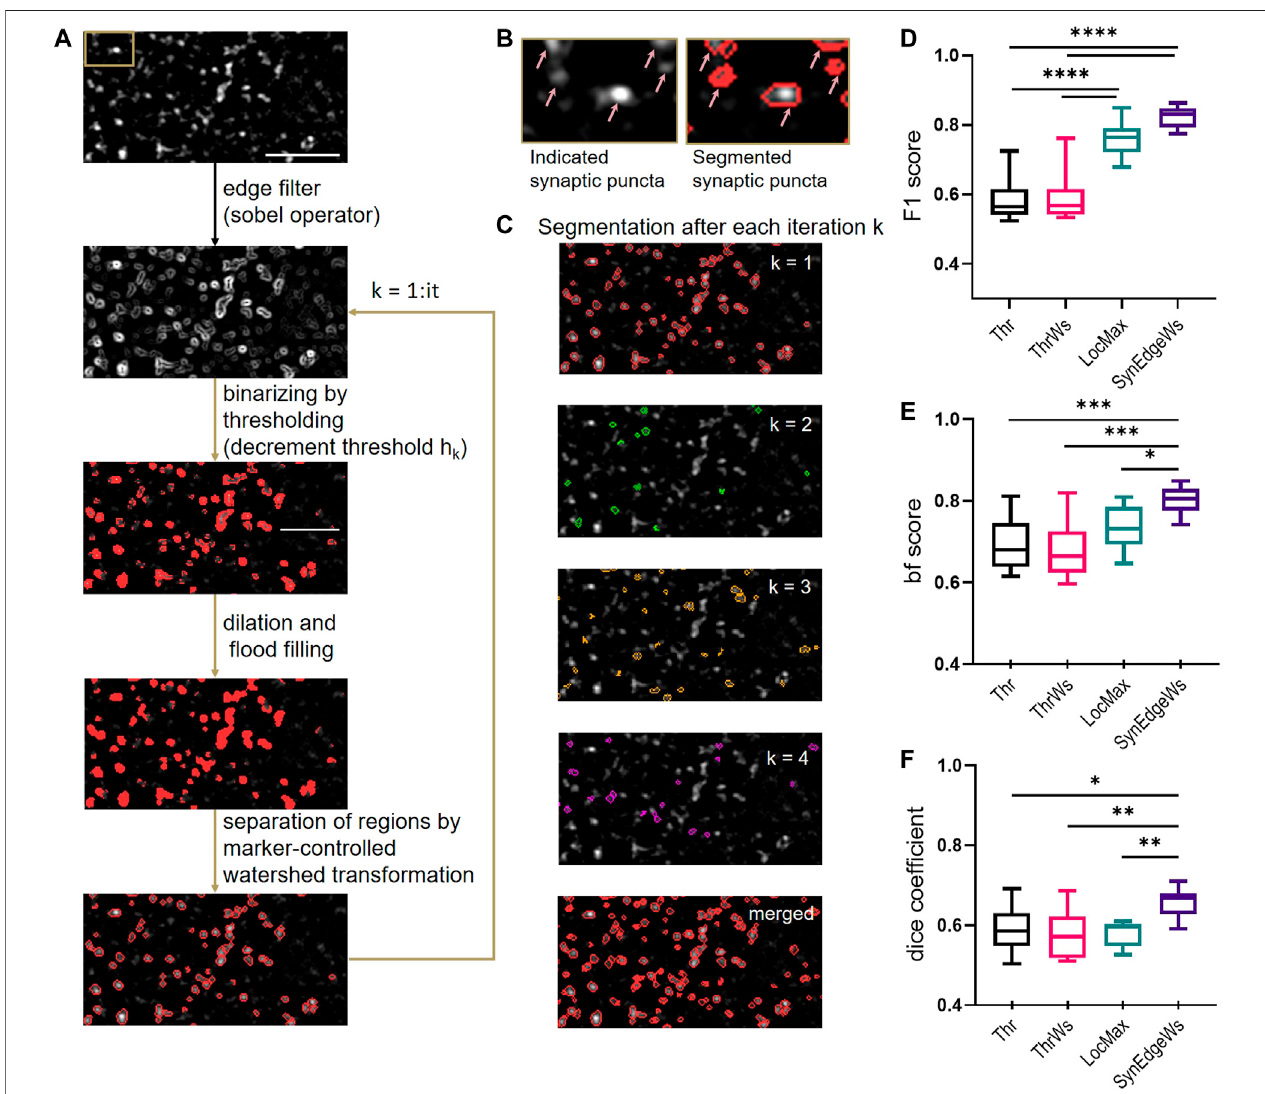
FIGURE 1 | Design and benchmarking of SynEdgeWs segmentation algorithm. (A) Illustration of puncta detection procedure by iterative gradient threshold application in SynEdgeWs exempli fi ed on synapsin marker staining. The upper image is the initial image (synaptic staining of cultured neurons). SynEdgeWs applies an edge fi lter (sobel operator) and iteratively performs a rough segmentation by gradient threshold re fi ned by followed dilation/ fl ood fi lling operation and marker controlled watershed transformation. (B) Close-up (section indicated in A, upper image) of synaptic puncta marked by arrows (left) and their segmentation (right). (C) Visualization of detected ROIs after each iteration ( n = 4, step 1 – 4) on the initial image. The last row shows merged segmentation mask after four iterations on the initial image. (D – F) Performance of SynEdgeWs (with iteration number it = 2) was benchmarked against thresholding (Thr), thresholding with subsequent marker-controlled WS(ThrWs),anddetectionoflocalmaximacontrolledbyglobalthreshold(LocMax)usingcroppedimagesstainedagainstsynapsin( n =10).ValidationofSynEdgeWsby F1score (D) ,bfscore (E) ,anddicecoef fi cient (F) .Forstatisticsone-wayANOVAwithmultiplecomparisonsbyTukeywasdone:**** p < 0.0001,*** p < 0.001,** p < 0.01, * p < 0.05. The box indicates the interquartile distance with median, and the whiskers are plotted in minimum to maximum